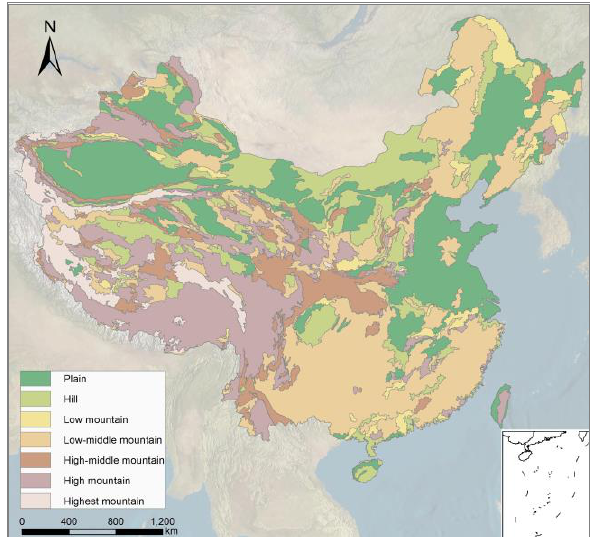
Figure 6. Result of China landform classification